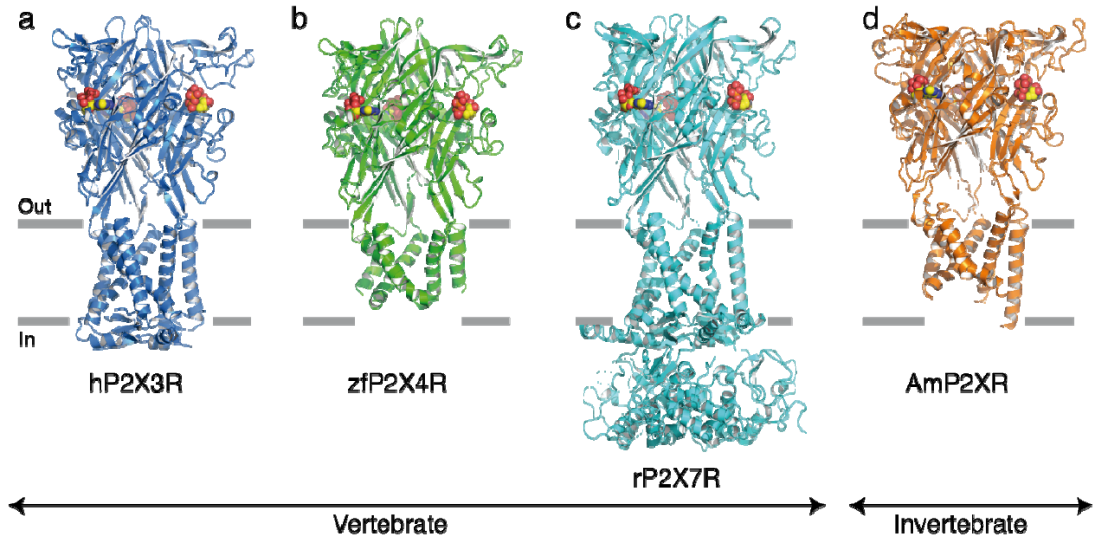
Figure 2. Structures of selected P2XRs. ( a ) Structure of the human P2X3R bound to ATP [34]. The hP2X3R is shown in blue; ATP is shown as spheres in a–d (carbon is yellow, oxygen is red, nitrogen is blue, and phosphorus is orange). Horizontal grey bars indicate the approximate location of the membrane bilayer defining the extracellular (out) and intracellular (in) milieu. ( b ) Structure of the zebrafish P2X4R bound to ATP [35]. The zf P2X4R is shown as a green. ( c ) Structure of the rat P2X7R bound to ATP [36]. The rP2X7R is shown in cyan. ( d ) Structure of the invertebrate Amblyomma maculatum P2XR receptor bound to ATP [37]. The AmP2XR is shown in orange. Note the structural similarity between vertebrate and invertebrate P2XRs. For structures having undergone heavy truncations, some membrane spanning helices, as well as the N- and C-termini are lacking in their intracellular sides. Reproduced from [31] with permission.